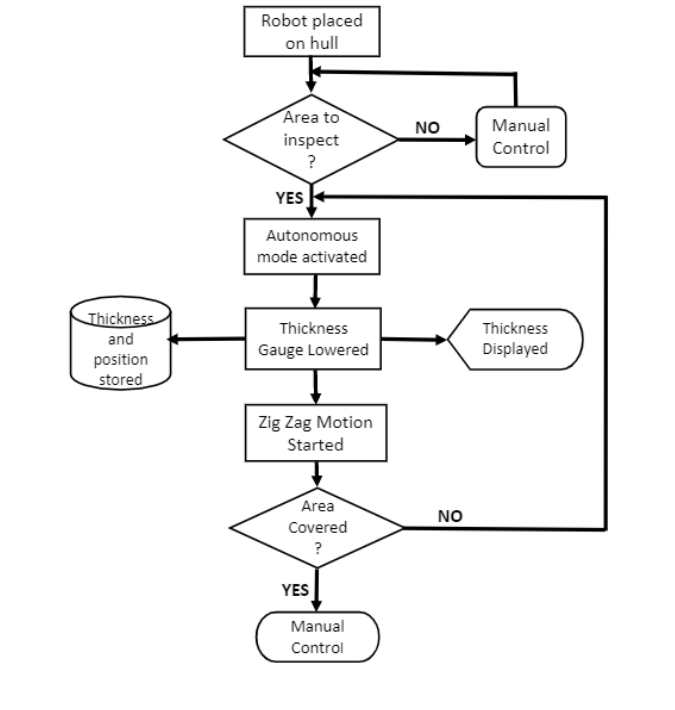
Figure 7. State Machine